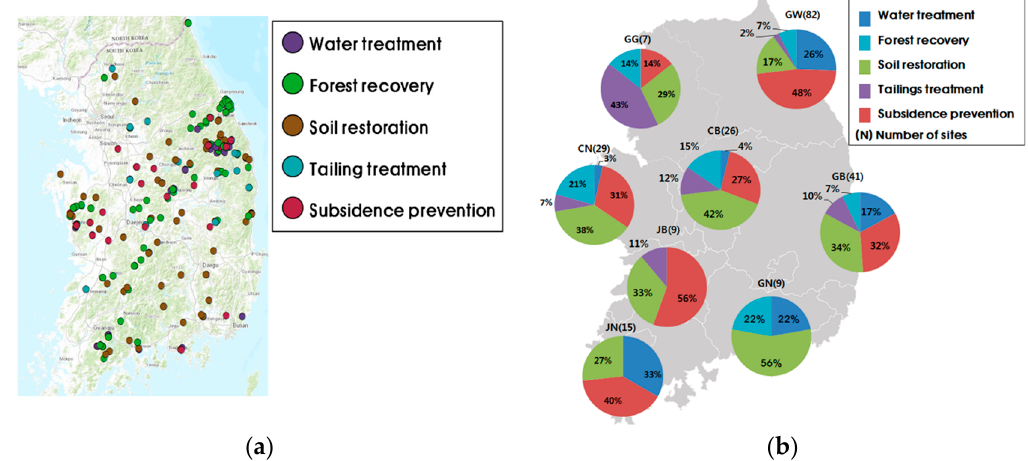
Figure 5. Spatial DB for abandoned mine reclamation sites in Korea: ( a ) Locations of abandoned mine reclamation sites; ( b ) Composition according to reclamation type in each administrative district (Choi and Song [54]).